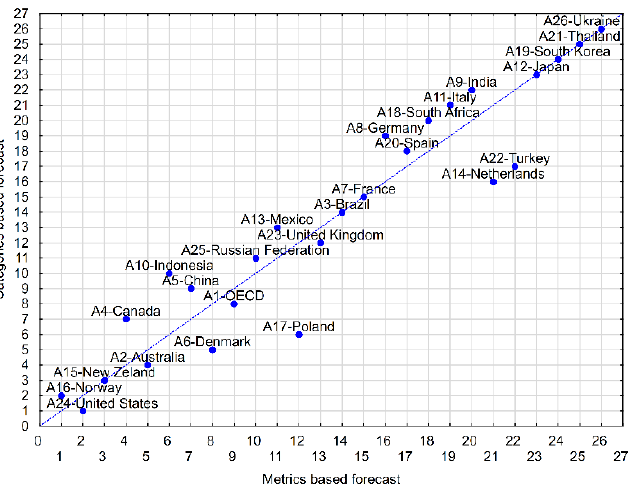
Figure 4. Scattering between the forecasted rankings obtained on the basis of metrics and categories.